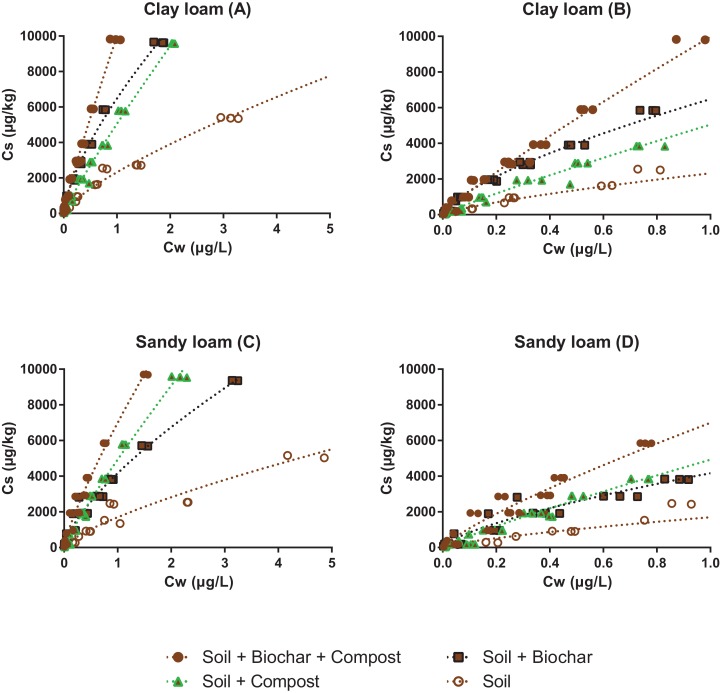
Sorption isotherms of pyrene to two soils before (open brown circles) and after addition of 5% biochar (black squares), 10% compost (green triangles) or both (full brown circles).Graph (B) and (D) are zooms of graphs (A) and (C), respectively. Note that the highest concentrations measured for the soils alone are not shown, but they were considered in the isotherm fit.